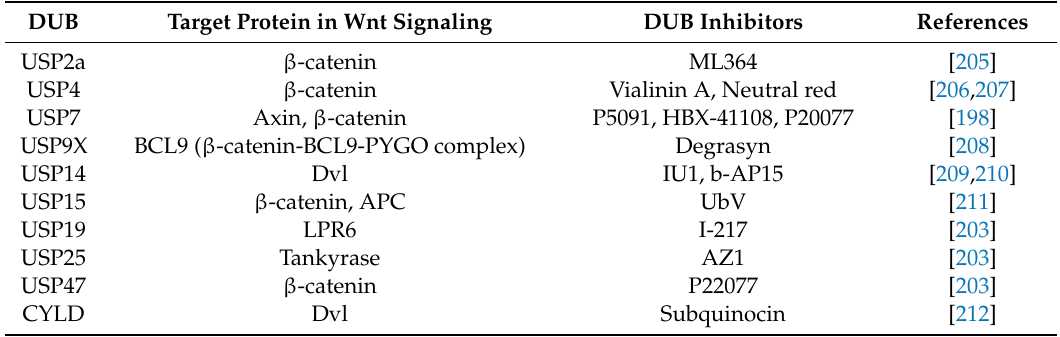
Identified DUB inhibitors that have influence on signaling components in the Wnt signaling